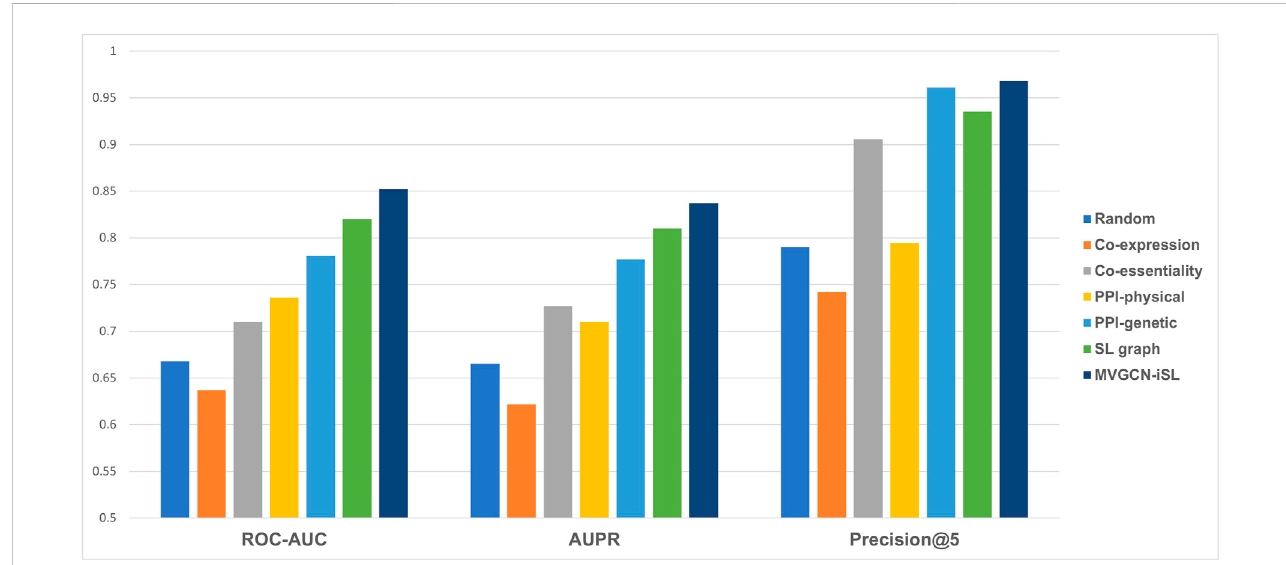
FIGURE 2 Model performance comparison across different types of input molecular networks under leave-gene-combination-out setting in K562 cell line. Performance is compared among fi ve different input molecular networks, a random model and our fi nal model, MVGCN-iSL, in terms of three evaluation metrics: ROC-AUC, AUPR and Precision@5. “ Random ” is a model using randomly generated network as the